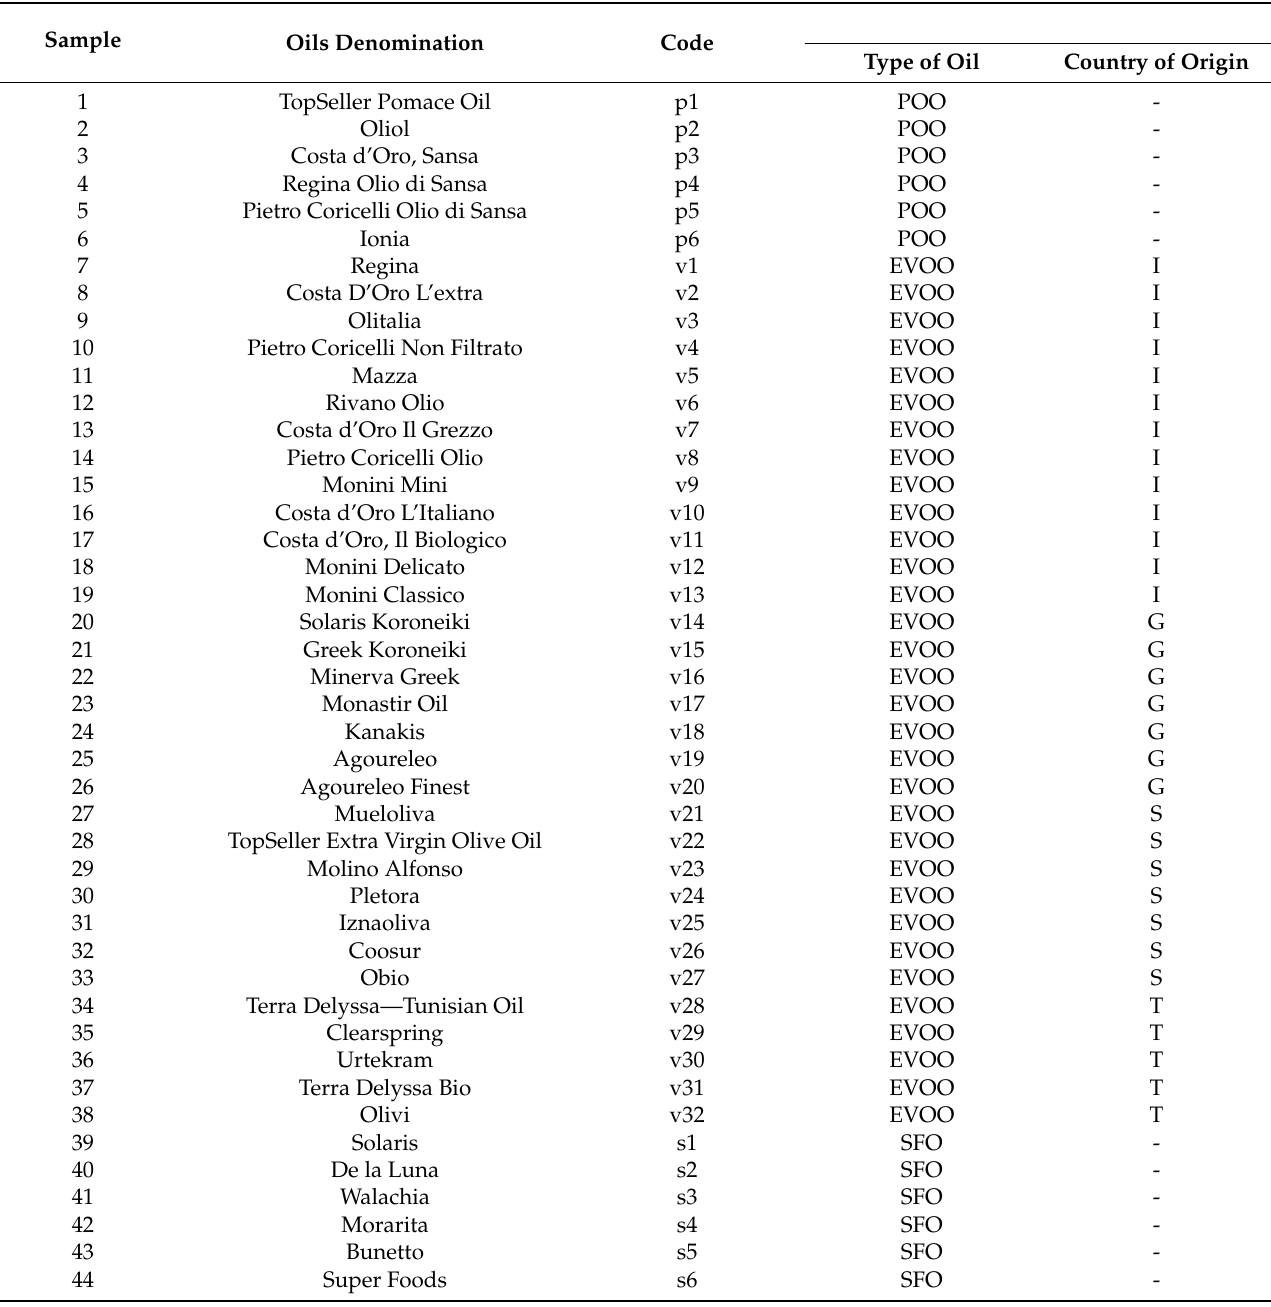
Table 1. Oil denomination, code, type of oil, and country of origin for the 44 oil samples under